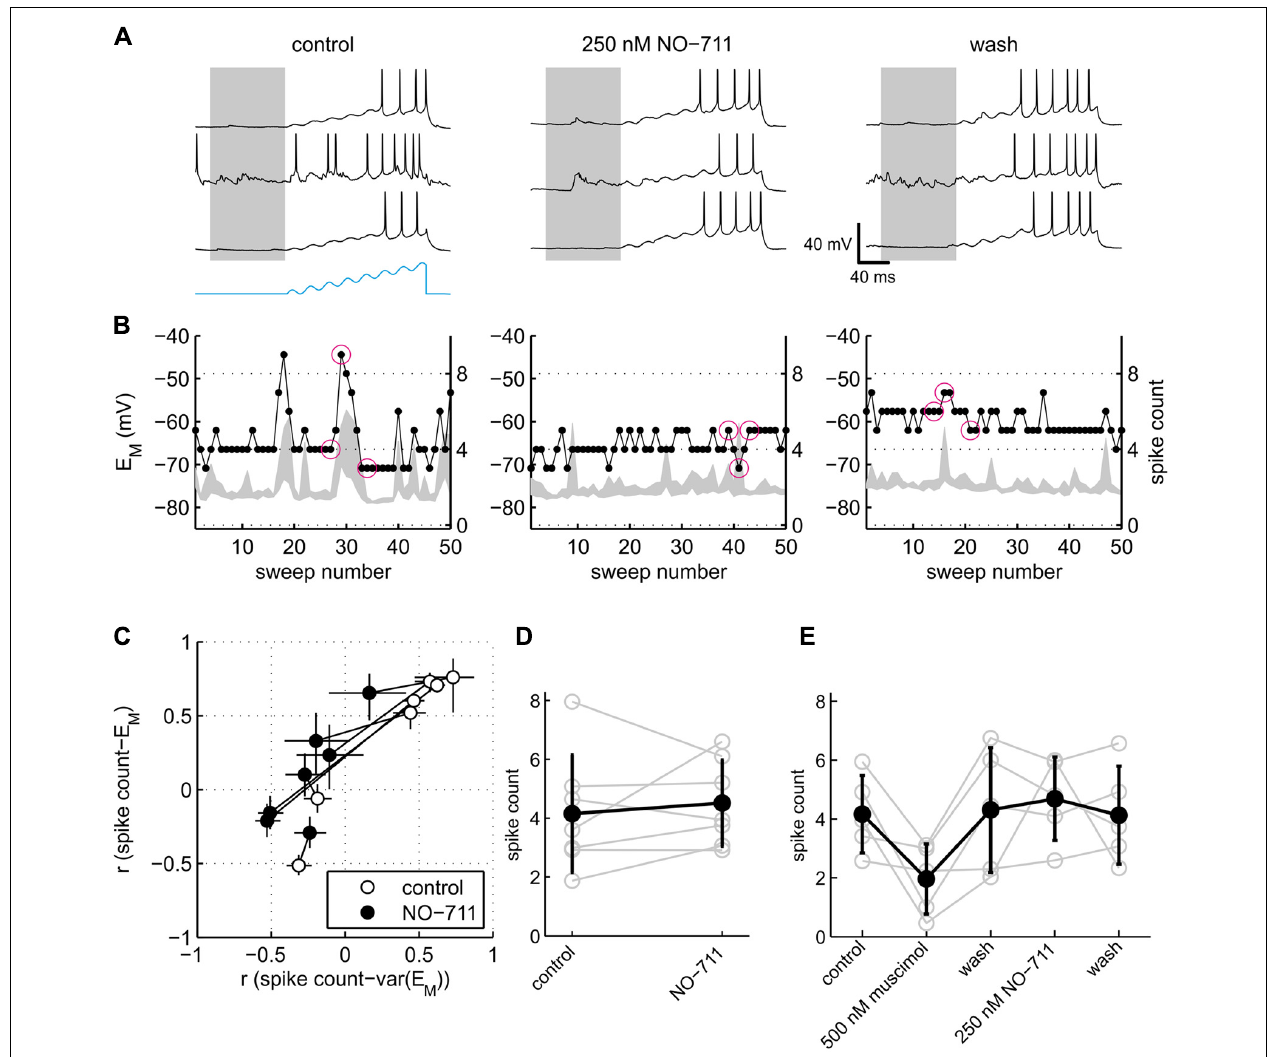
FIGURE 7 | Effects of GAT-1 inhibition and tonic activation of GABA A receptors on somatic excitability. (A) Exemplary neuronal membrane voltage traces recorded during injection of a sinusoidal ramp current during control (left), 250 nM NO-711 (center), and after washout of the drug (right). The amplitude of the current waveform (blue trace at bottom in left block of traces) was adjusted for each neuron individually such that during control conditions action potentials were elicited starting at about the fifth of the eight current peaks. Membrane potential traces are clipped at 0 mV to enhance visibility of low-amplitude potential fluctuations. Gray patches delineate the pre-stimulus window of [ − 100 0] ms in which the median and variability of E M were computed. (B) For the same experiments as shown in (A) , the plots depict the 2.5–97.5 interpercentile range of E M in the pre-stimulus window (gray shades) and the spike count during the current